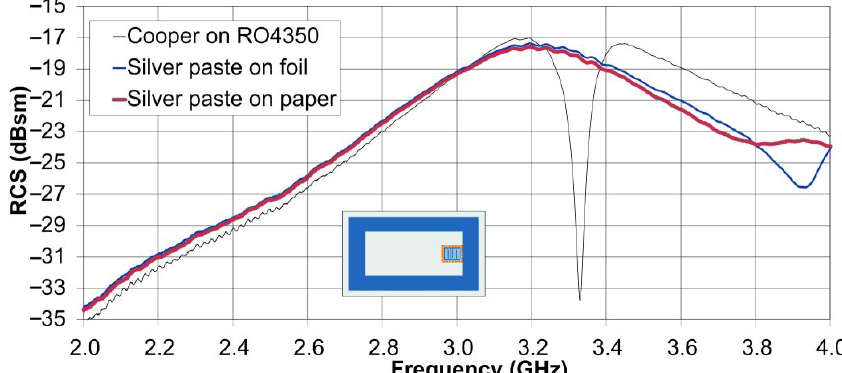
Figure 16. Measured RCS of IC U-dipole coupled in the metallic loop sensor tag manufactured by the screen-printing technology on Folanorm polyester film and a paper substrate compared to a standard copper-on-microwave substrate technology.